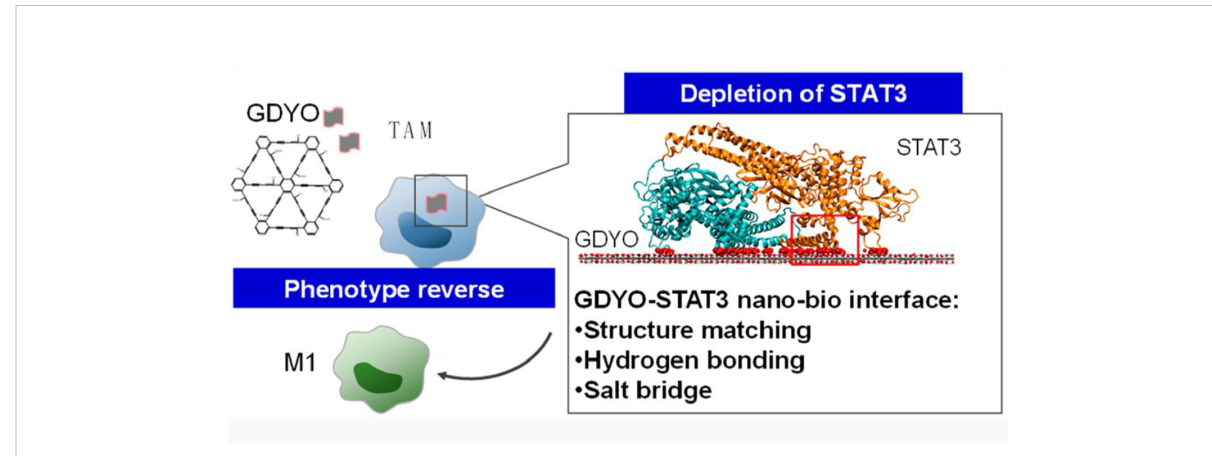
FIGURE 3 The GYDO-nanosheet in TAMs binds the surface of STAT3 to hinder its function, thereby reeducating TAMs towards M1-like pro-in fl ammatory phenotype. Reproduced from ref